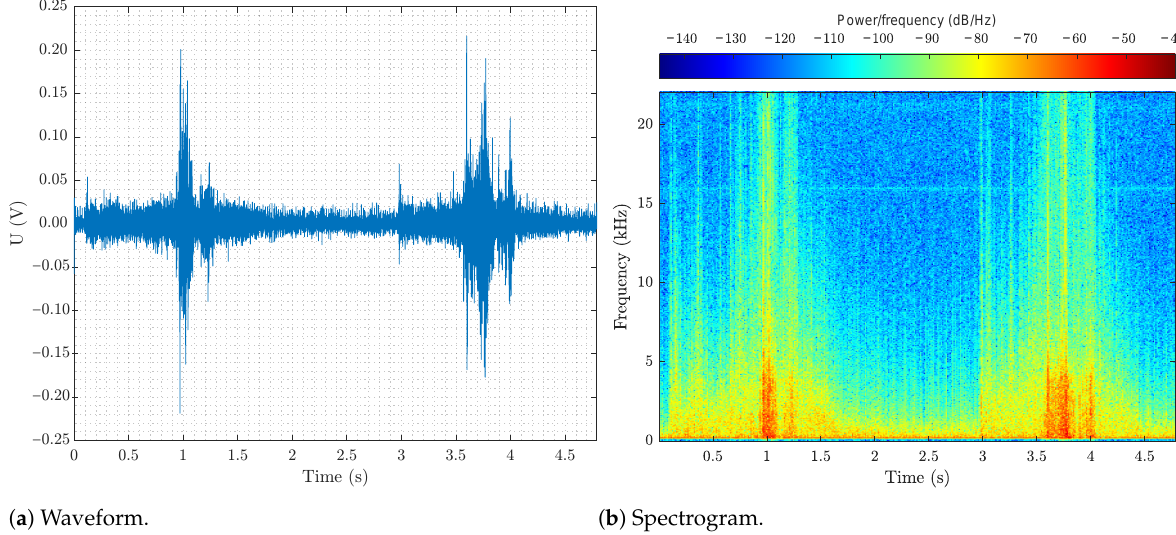
Figure 7. Example of a signal indicating two events of manipulation of fibers in a